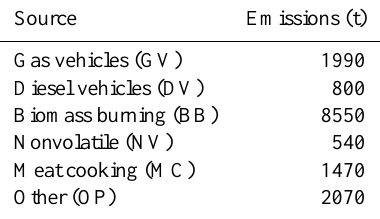
Table 2. Domain and modeling period (4 May to 30 June 2010) total 2011 NEI POA emissions (tons) for gasoline vehicles, diesel vehi- cles, biomass burning, nonvolatile (e.g., fugitive dust), meat cook- ing, and “other”